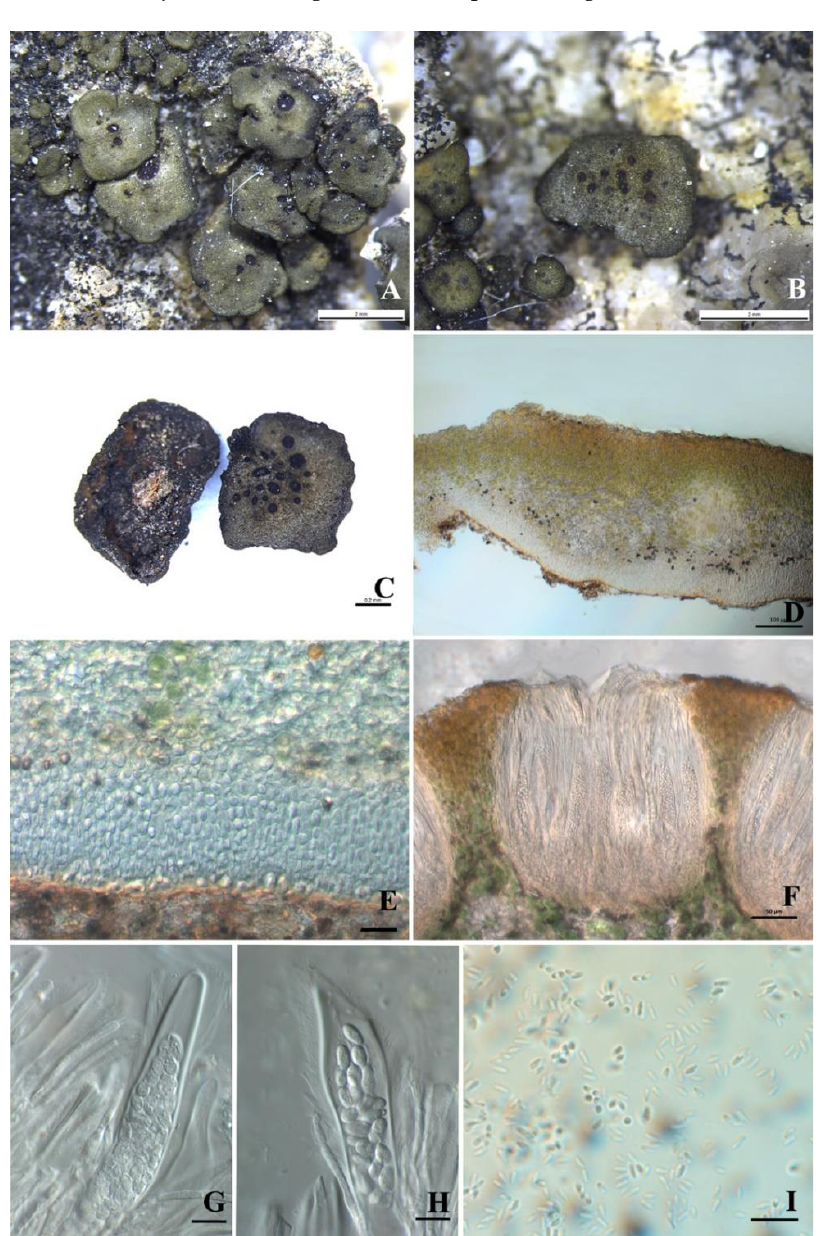
Figure 2. The thallus habit and anatomic structure of Peltula confusa (holotype). ( A – C ) Squamulose thallus and immersed apothecia. ( D ) Thallus section. ( E ) Thick lower cortex. ( F ) Section of apothecium. ( G – H ) Bitunicate ascus with a lacerate outer-wall-like gelatinous sheath. ( I ) Conidia. Bars: ( A − B ) = 2 mm, ( C ) = 0.2 mm, ( E ) = 20 μm, ( F ) = 50 μm, ( G − I ) = 10 μm.